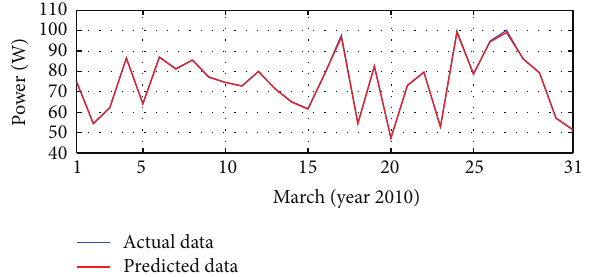
Figure 7: Results for real data and FFBP for March 2010.